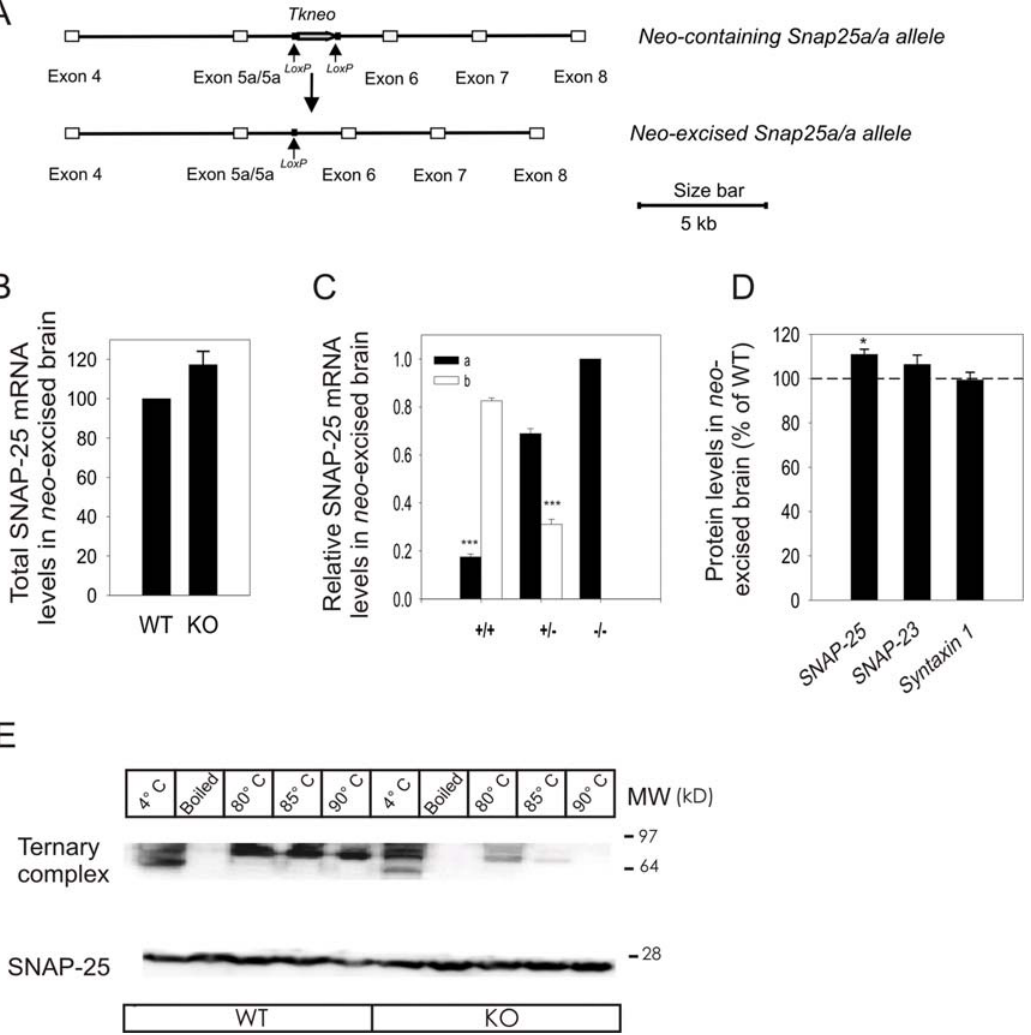
Figure 2. Invivo Excision of the Tkneo Gene Results in Altered Gene Expression. (A) A schematic diagram demonstrating the in vivo excision of the Tkneo gene. Heterozygous neo- containing SNAP-25b deficient females were mated with heterozygous Prm1Cre males. Male offspring carrying both the mutation in the Snap25 gene and the Cre transgene were mated with B6 females. In vivo excision was demonstrated by PCR, and the Cre transgene was crossed out from the confirmed neo- excised SNAP-25b deficient mice. (B) To investigate total SNAP-25 mRNA levels in mouse brain of neo- excised SNAP-25b deficient mutants at PN14-15, the same radioactive semi-quantitative RT-PCR assay as for neo- containing mouse mutants (see Figure 1B) was used. Total SNAP-25 mRNA levels (SNAP-25a + SNAP-25b) in neo- excised SNAP-25b deficient mice brain at PN14-15 were 117.3 6 6.8% of WT (n=6 mice foreach genotype, repeated threetimes each, mean 6 S.E.M., * p= 0.0625, Wilcoxon’s signed-rank test).(C) SNAP-25a/SNAP-25bmRNA ratio at PN14 were for WT littermates 17.5 6 1.2% and 82.5 6 1.2%, respectively (mean 6 S.E.M., *** p , 0.0001 Student’s t-test), in heterozygous neo- excised SNAP-25b mutants 68.9 6 2.1% SNAP-25a and 31.1 6 2.1% SNAP-25b (*** p , 0.0001), and in homozygous neo- excised SNAP-25b deficient mice 100% SNAP-25a (n=5 mice for each genotype, repeated twice). (D) Protein levels in brain at PN14-15. In neo- excised SNAP-25b deficient mice, there was 110.9 6 2.3% (* p= 0.0312) SNAP-25 protein, 106.4 6 4.2% ( p= 0.3125, n.s) SNAP-23, and 99.4 6 3.5% ( p= 0.8438, n.s.) syntaxin 1 relative to WT expression levels (n=6 mice for each genotype, run in three replicates, mean 6 S.E.M., Wilcoxon’s signed-rank test). (E) Immunoblot demonstrating temperature dependence and stability of the ternary SDS resistant SNARE complex in neo -excised SNAP-25b deficient (KO) and WT mouse brain cortex. The samples separated in lanes 1–5 (from left to right) are from adult WT brain cortex, and the preparations in lanes 6–10 are from neo -excised SNAP-25b deficient mutants (KO only expressing SNAP-25a). The high molecular weight , 97 kD complex was identified as SNAP-25 in ternary SNARE complex, while the band migrating as , 28 kDa is free SNAP-25 protein. KO brain homogenates heated to 80 u C showed 44 6 8% SNAP-25 still present in ternary complex compared to 4 u C samples, significantly lower than for SNAP-25 in WT brain (71.2 6 7.2, * p= 0.01). At 85 u C and 90 u C, the difference in percentage of SNAP-25 remaining in complex between WT and KO was as following: 59.8 6 7 and 36.9 6 3.4 (* p= 0.018), and 48.3 6 12.3 and 4.5 6 2.2 (** p= 0.0081), respectively. All experiments were repeated at least three times. Results were analyzed with unpaired Student’s t-test and summarized as mean 6 S.E.M.